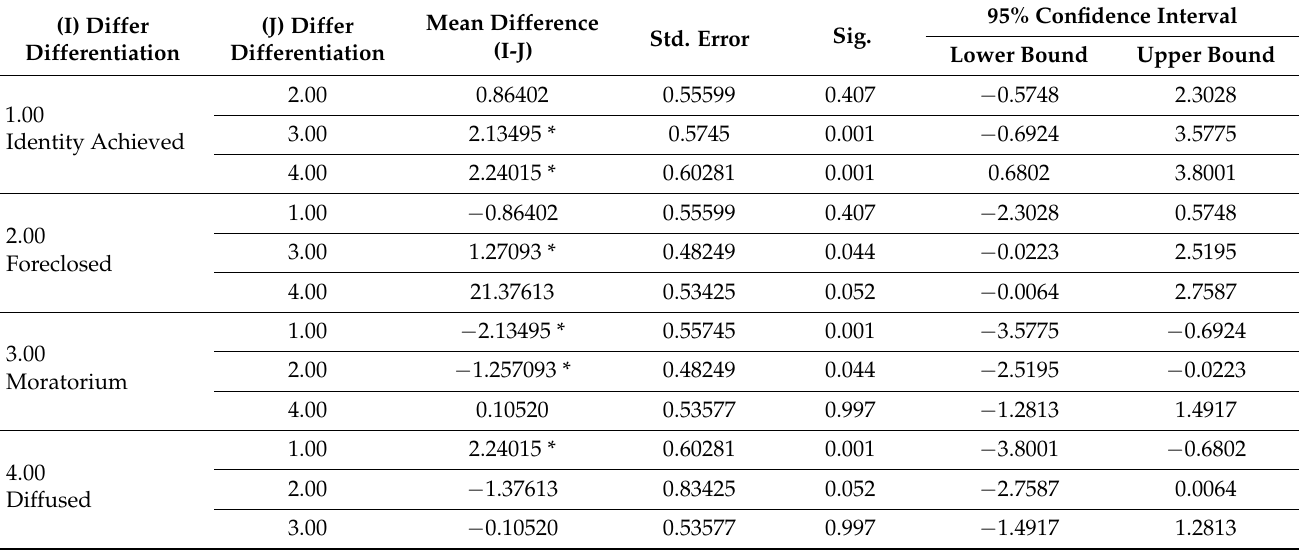
Table 4. Post Hoc Test: Tukey Multiple Comparisons (Family History Knowledge and Marcia’s Identity Stages (1980).